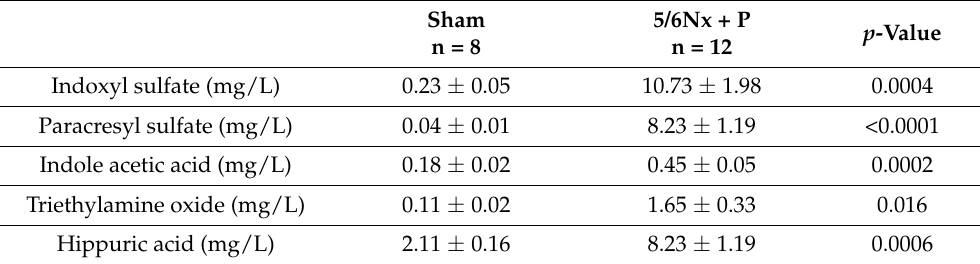
Sham 5/6Nx + P p -Value n = 8 n = 12